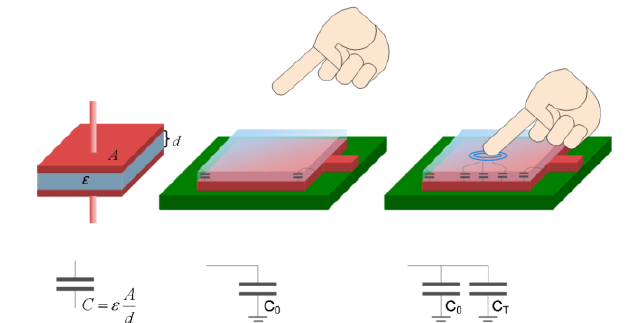
Fig. 1. Simplified model of change of capacitance from the value C 0 to C 0 +C T when a finger is touching the dielectric layer top surface.